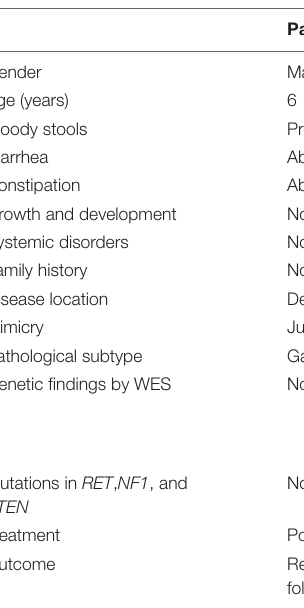
TABLE 1 | The main manifestations of the case